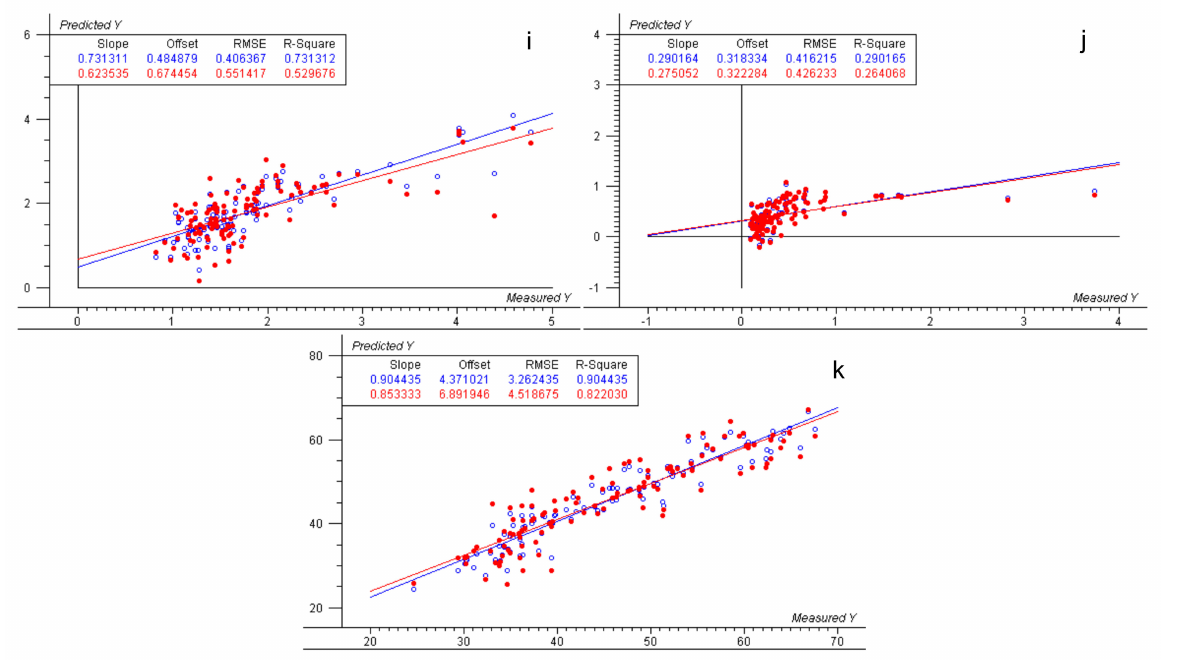
Figure A2. Scatter plots of observed vs. predicted values for ( a ) OC (%); ( b ) pH; ( c ) EC ( µ S cm − 1 ); ( d )